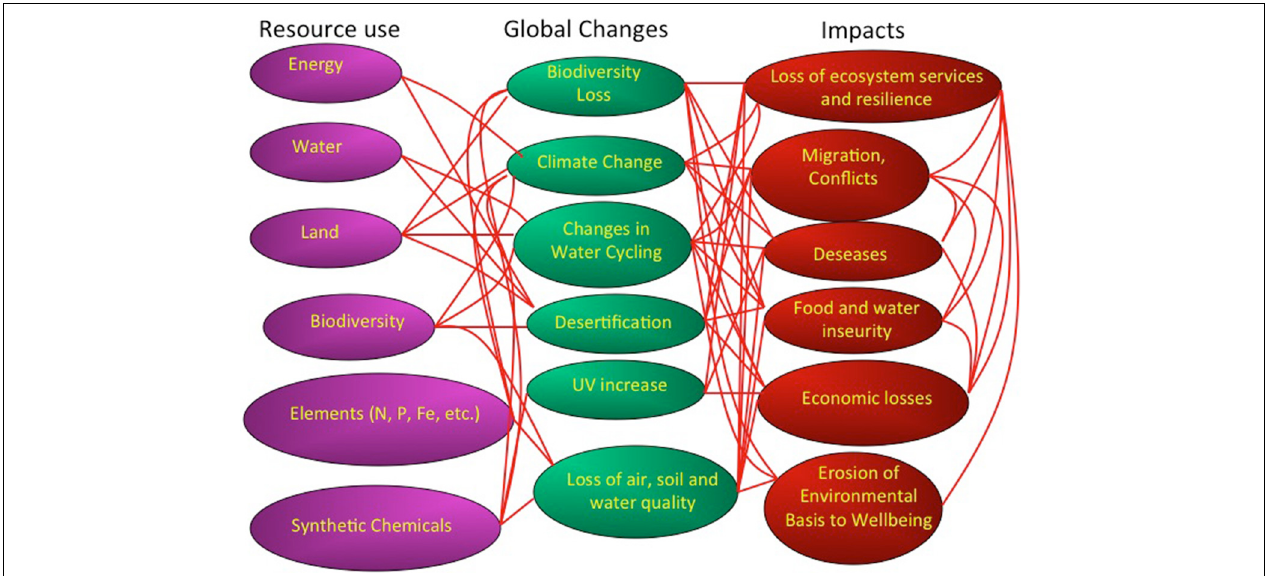
FIGURE 1 | A description of the human pressures, in terms of resource use, global changes, and impacts conforming the global change syndrome. Red lines indicate links between these components. Modified from Duarte et al. (2006).